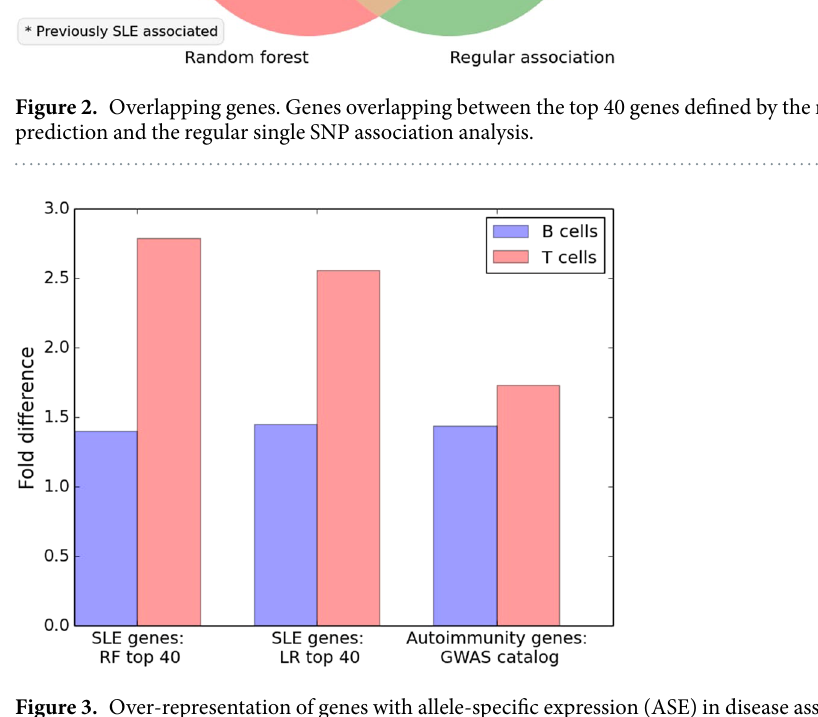
Figure 3. Over-representation of genes with allele-specific expression (ASE) in disease associated genes. Fold difference of expressed predicted SLE genes and autoimmunity associated genes with ASE in more than 80% of the individuals compared to all other genes. The risk genes in T-cells were significantly overrepresented in all gene sets, with the top 40 genes from random forest classification (p = 0.0079), top 40 genes from logistic regression (p = 0.015), and autoimmunity associated genes (p < 0.0001). Additionally, the enrichment of the autoimmunity associated risk genes in B-cells was also significant (p =